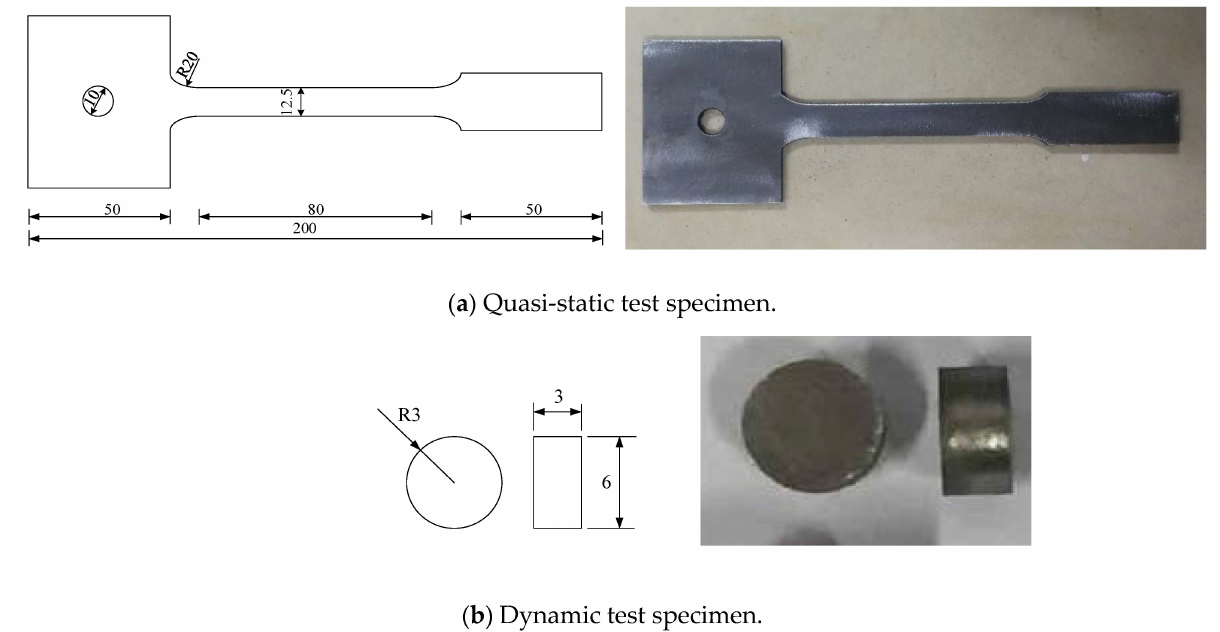
Figure 1. Geometry test specimen (unit: mm).